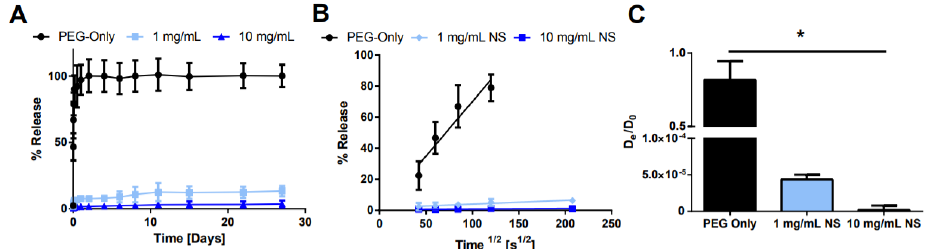
Figure 8. Effect of NS concentration on release. ( A ) Bulk release of AO from hydrogels with varying NS concentration. ( B ) Plot of fractional release as a function of the square root of time. ( C ) Calculated effective diffusion coefficient for each condition. * denotes statistically significant difference between all groups ( n = 3, p < 0.05) as indicated by an ANOVA followed by Tukey’s post hoc test.